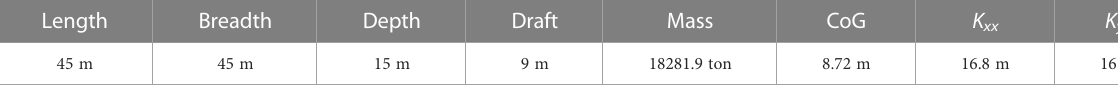
TABLE 2 Particulars of the fl oating module (Jiang et al., 2021).